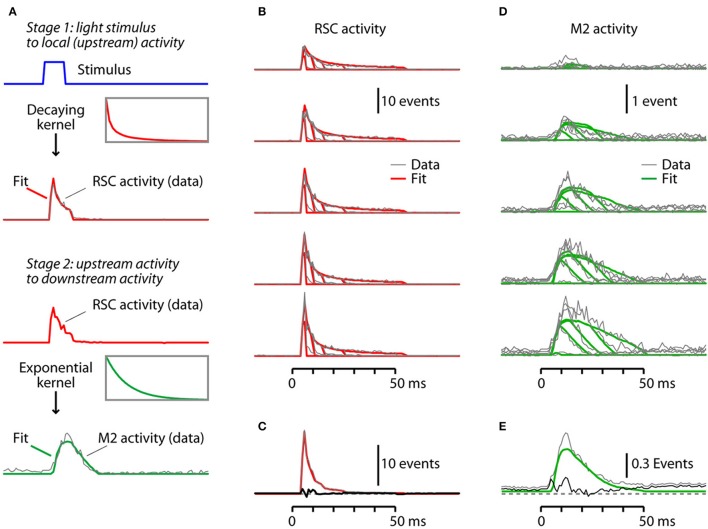
A simple two-stage model captures the major features of orthodromic driving. (A) Depiction of the modeling. The first stage is the conversion of light pulses into local activity in the RSC, which is modeled by convolving the step pulses of light with a step function scaled by a decay process. The second stage is the conversion of the upstream RSC activity into downstream M2 activity, which is modeled by convolving the RSC activity with an exponential process with a temporal lag. The models were fitted to the data over the 0-60 ms post-stimulus interval. See text for additional details. (B) The fitted RSC responses (red) were generated by modeling the light pulse→RSC transfer function as described in (A). The AAV9-CaMKII-hChR2-eYFP data traces (gray) are shown superimposed. (C) Plot of the residuals (black trace), calculated by subtracting the mean fitted traces (red) from the mean data traces (gray). (D) The fitted M2 responses (green) were generated by modeling the RSC→M2 transfer function as described in (A). The data traces (gray) are shown superimposed. (E) Plot of the residuals (black trace), calculated by subtracting the mean fitted traces (green) from the mean data traces (gray).